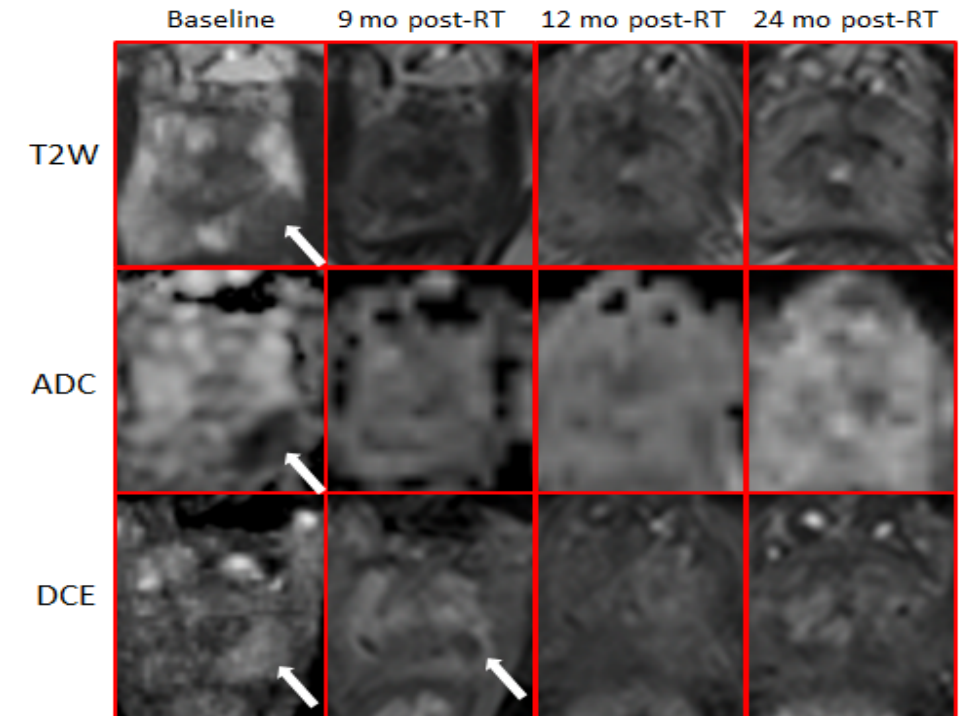
Figure 2. Longitudinal changes of mpMRI following RT. T2-weighted, ADC, and early enhancing images from the DCE-MRI series are shown. At baseline, the arrows indicate the GTV, defined by hypointensity on T2-weighted, ADC, and enhancing on DCE. There is no hyperintensities on T2-weighted and ADC post-RT. DCE at 3-months post-RT indicates complete obliteration of the GTV (white arrow).